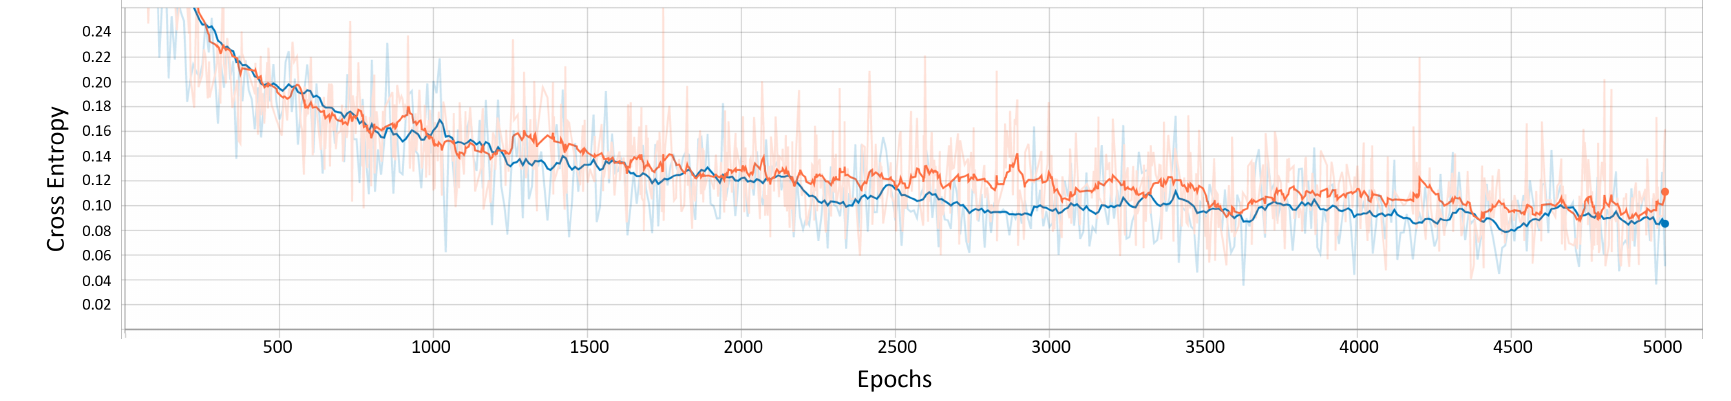
Figure 6. Graph of the cross entropy obtained along the 5000 epochs, red line = train data, blue line = validation